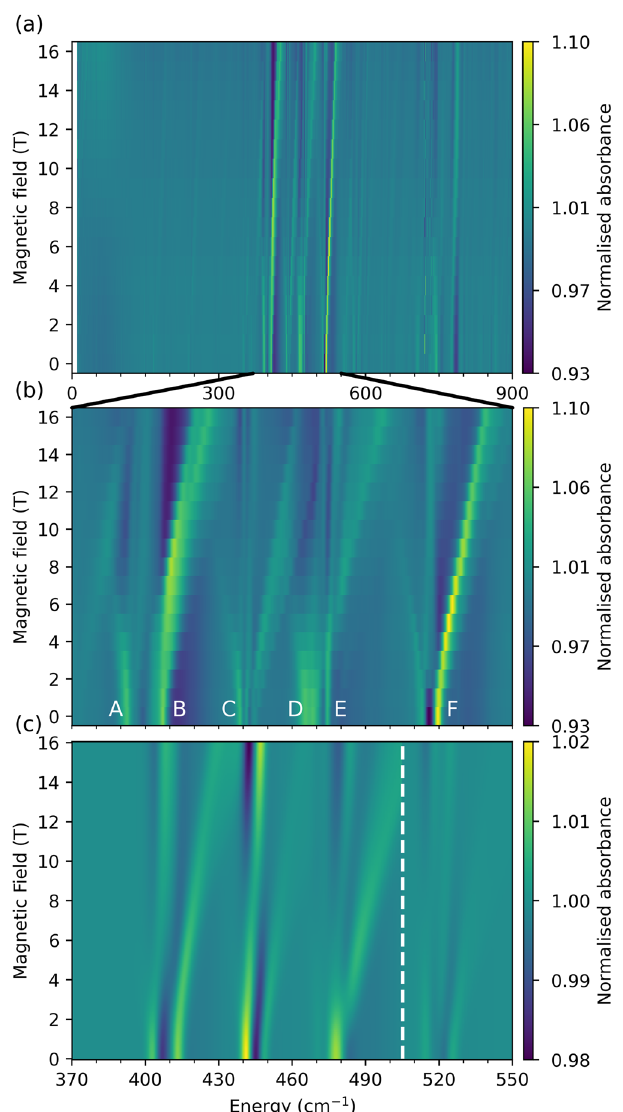
Fig. 3 Experimental and simulated FIRMS maps for 1. Experimental FIRMS map measured at 4.2 K in the range a 0 – 900 cm − 1 and b 370 – 550 cm − 1 ( fi eld dependent signals are labelled as A – F ). c Composite ab initio simulated FIRMS map for signals A – F using CASPT2-SO equilibrium CF parameters with experimental CF energies, CASSCF-SO vibronic couplings and ab initio transition intensities where the vibrational transition probabilities have been scaled according to Fig. S3, and the electronic transition probabilities have been scaled by 20 times (see text). This composite image was generated from two independent simulations including vibrational modes 34 – 42 and 43 – 45 (Figs. S14 and S15); the vertical dashed line indicates where the two data sets are joined. The colour bars show fractional changes in relative transmittance (normalised absorbance) due to the magnetic fi